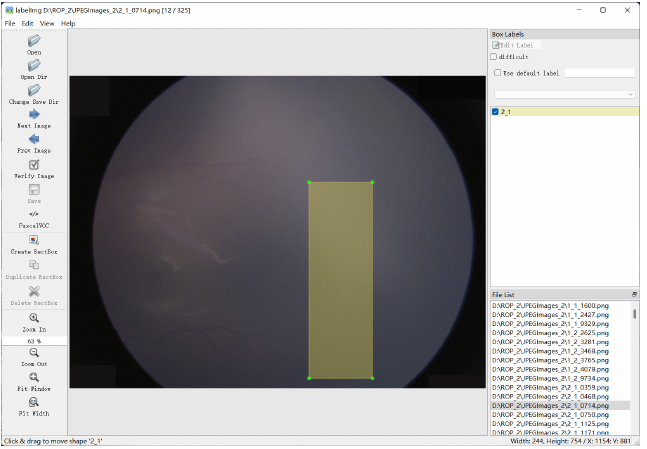
Figure 5. Manual labeling for ROP Images using LabelImg.